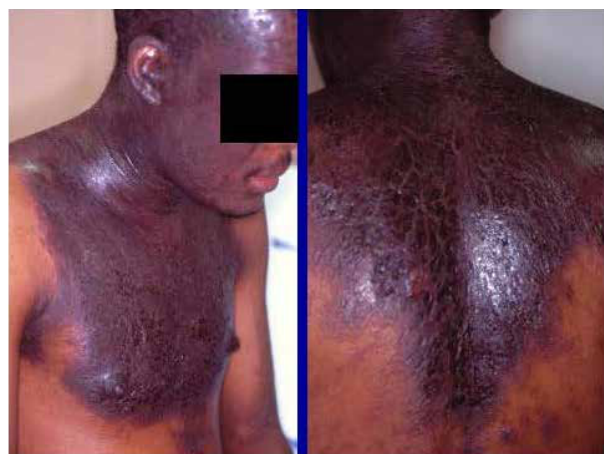
Figure 8. Extensive seborrhoeic dermatitis in HIV